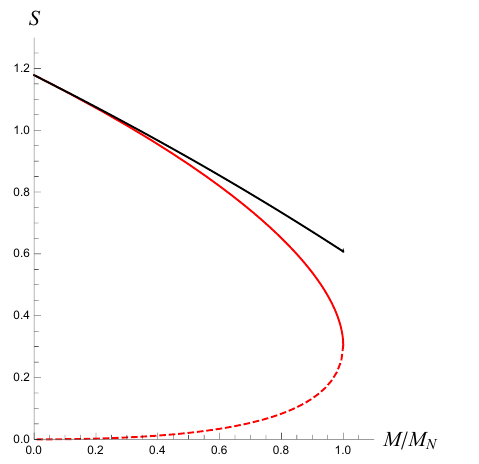
(red dashed curve) and S (3) gen ,c (red solid curve) as a gen ,h (black), given by the sum gen , tot